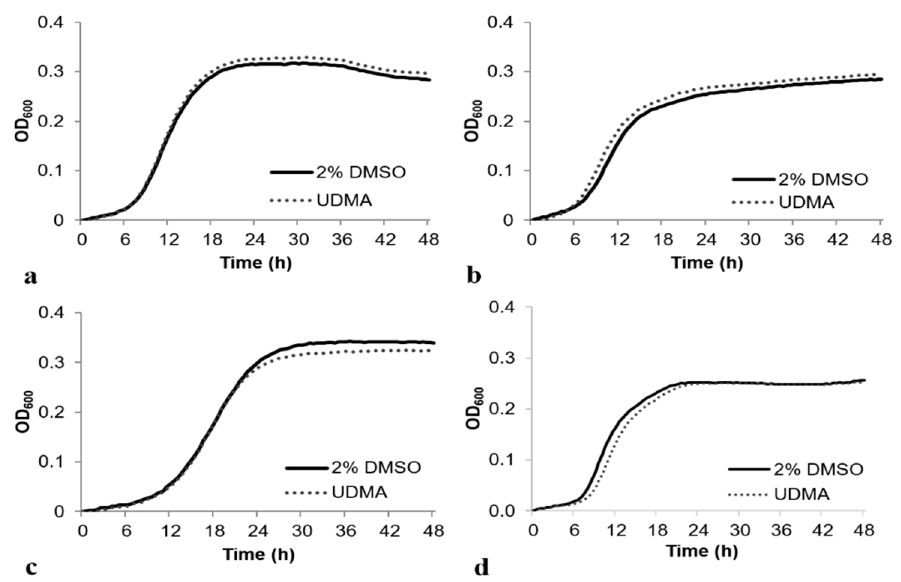
Figure 1. Growth of Streptococcus mutans UA159 in the presence and absence of urethane dimethacrylate (UDMA) in a tryptone-vitamin (TV) medium containing 0.5% glucose ( a ), 0.5% fructose ( b ), 0.5% mannose ( c ), or 0.5% sucrose ( d ). DMSO was used as a vehicle for UDMA, and cells grown in the absence of UDMA (2% DMSO) were used as the control.